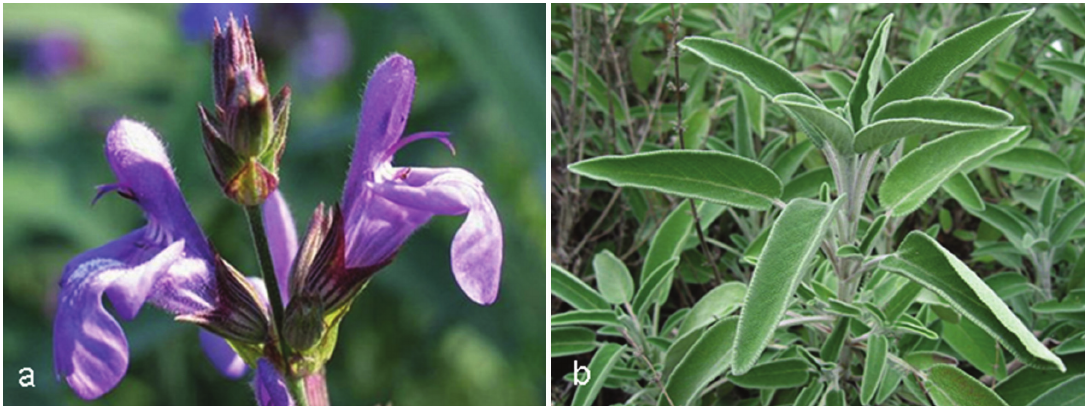
Figure 11. Salvia officinalis L.: flowers (a) and leaves (b).